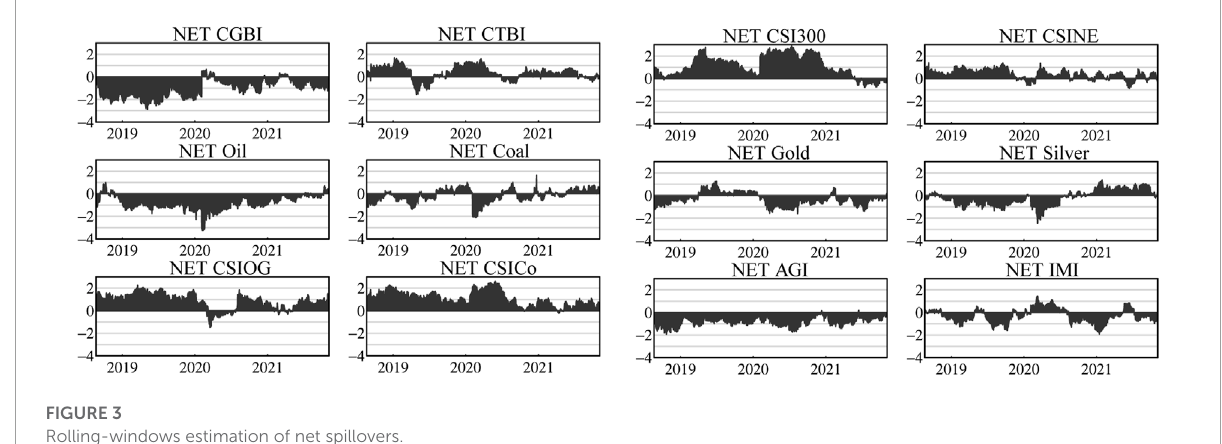
FIGURE 3 Rolling-windows estimation of net spillovers.